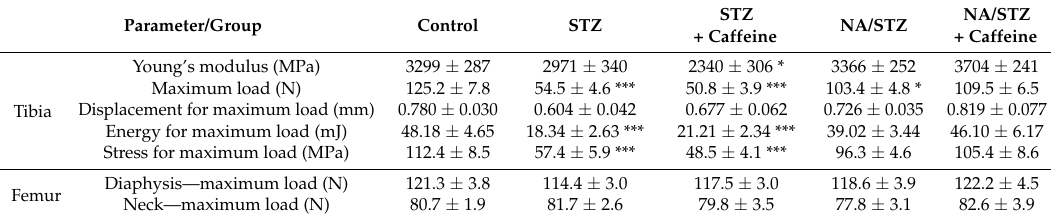
Table 3. Effect of caffeine administered orally (20 mg/kg daily for four weeks) on bone mechanical properties in rats treated with streptozotocin (STZ) or nicotinamide and streptozotocin (NA/STZ). Parameter/Group